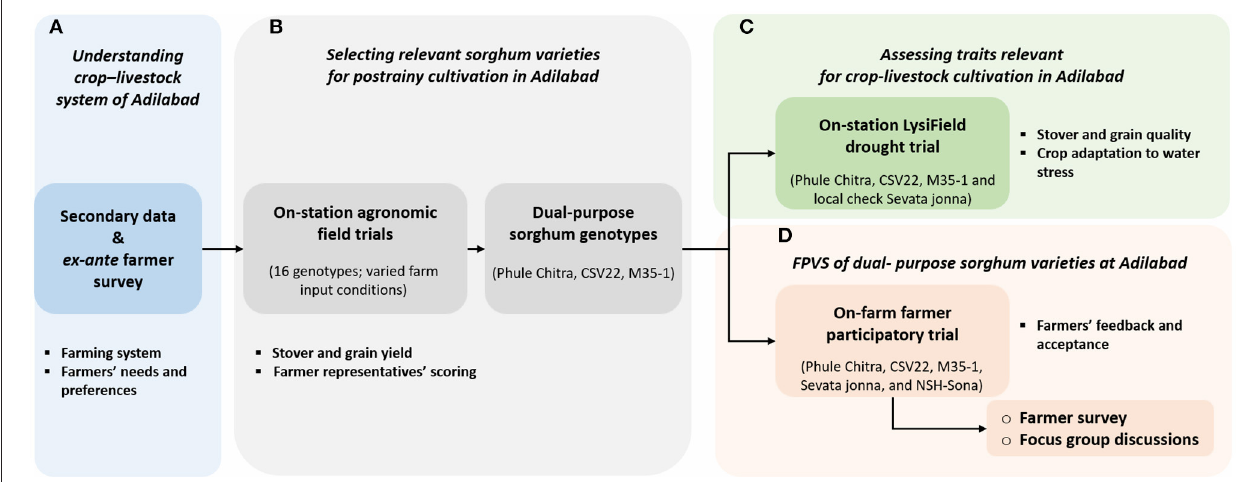
FIGURE 3 | Defined stages of project activities (A) Understanding crop–livestock system of Adilabad; (B) Selecting relevant sorghum varieties for postrainy cultivation; (C) Assessing traits relevant for crop-livestock cultivation; (D) FPVS of dual- purpose sorghum varieties at Adilabad.